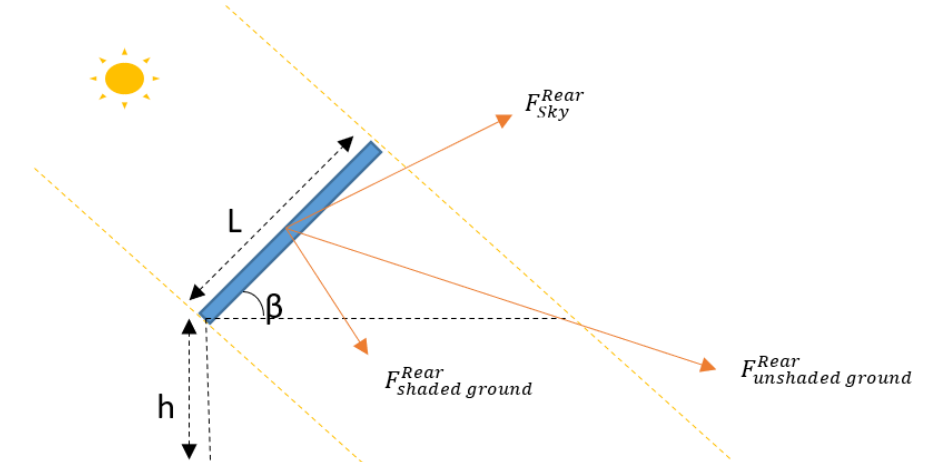
Figure 7. Schematic diagram of the rear-view factors of a bPV module.